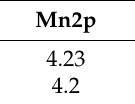
Table 1. The atomic ratio in the composites from XPS